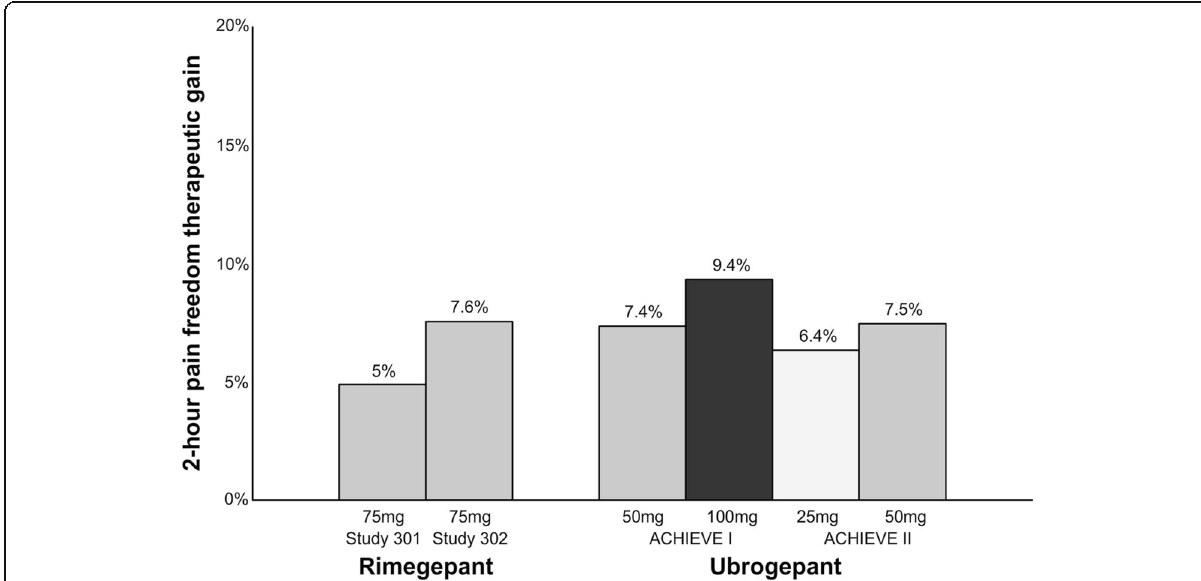
Fig. 6 Overview of the therapeutic gain* in 2-h pain freedom with gepants. A darker bar indicates a higher dose. *Therapeutic gain is defined as the difference between percentage of responders in active group compared to percentage of responders in placebo